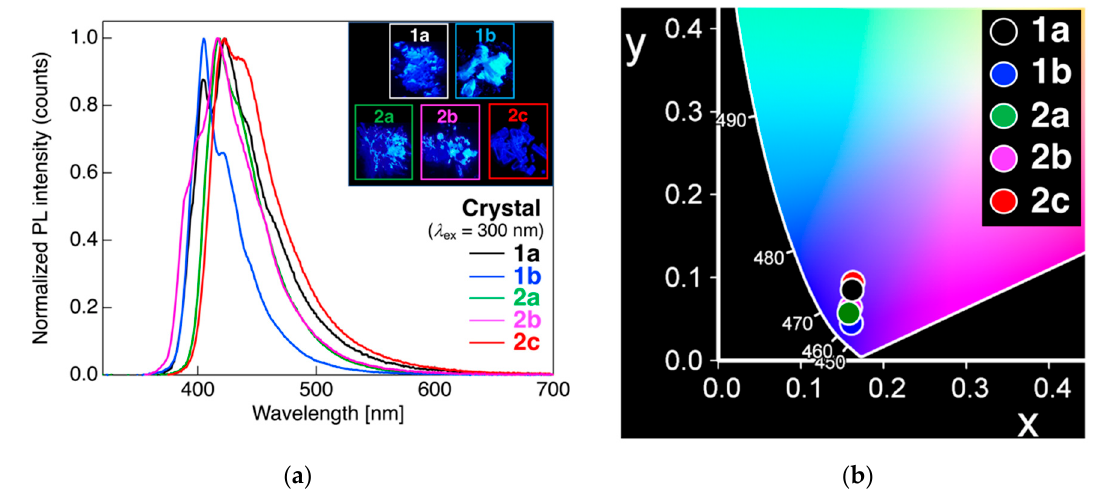
Figure 7. ( a ) PL spectra of 1a , 1b , and 2a – 2c in the crystalline form (inset: photographic images showing PL under UV irradiation at λ ex = 365 nm); ( b ) CIE color diagram obtained from the corresponding PL spectra. Table 3. Photophysical data for 1a , 1b , and 2a – 2c in the crystalline form.